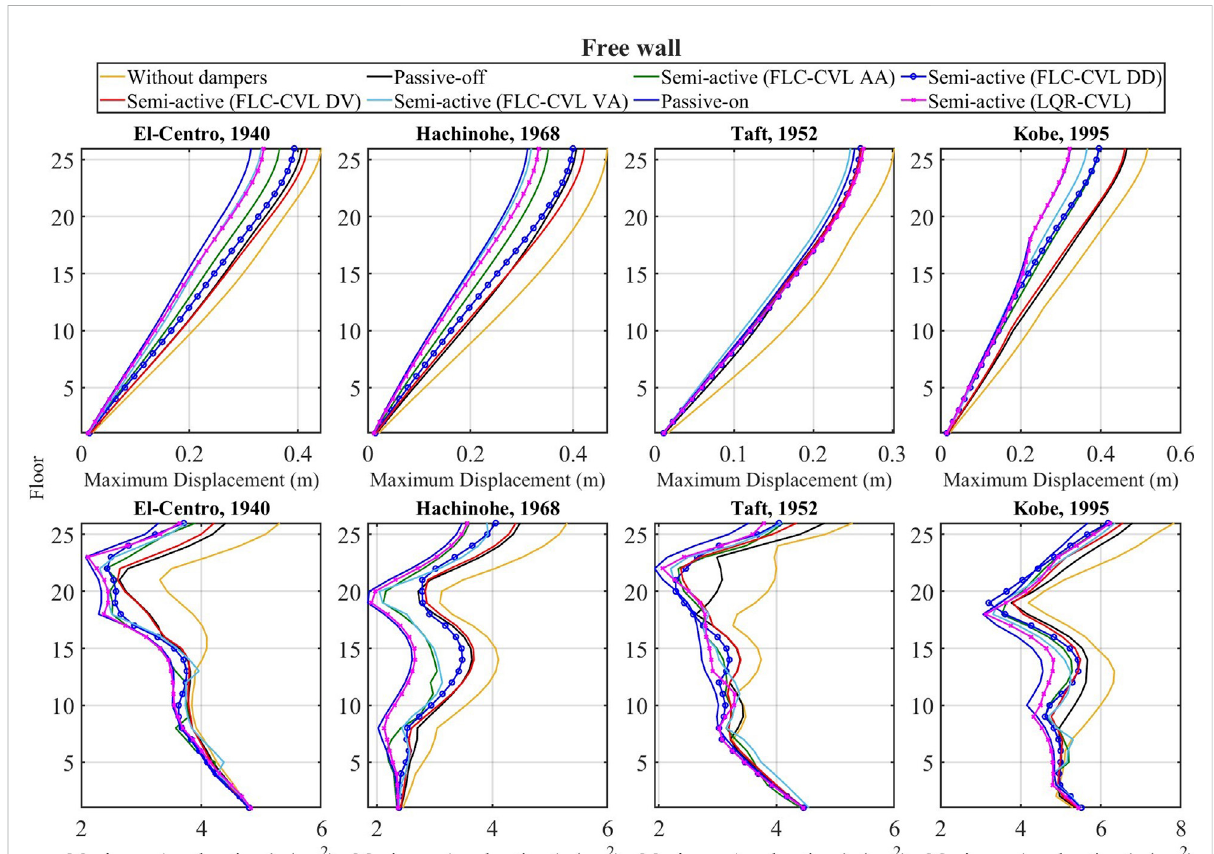
FIGURE 12 Maximum responses pro fi les of free